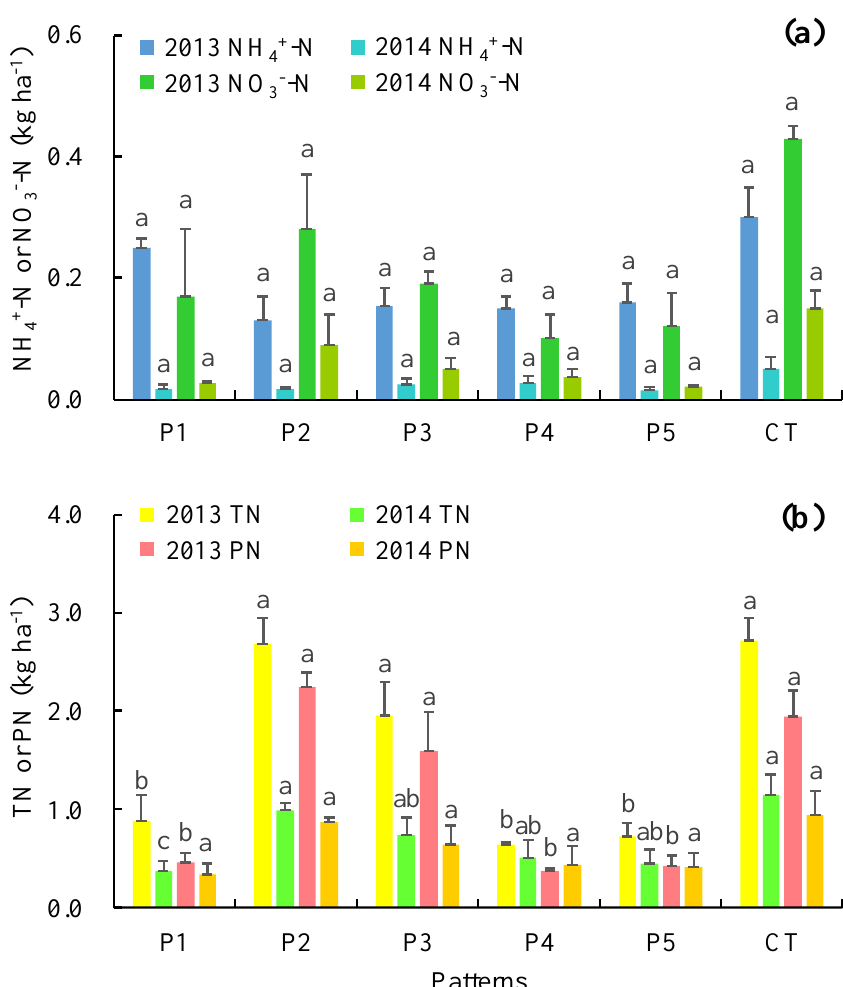
Figure 6. Nitrogen (N) loss from runo ff under di ff erent crop-mulberry planting patterns. The same lettersabovethebarsindicatenosignificantdi ff erenceanddi ff erentlettersindicatesignificantdi ff erences between these groups (p < Table 1. Linear fitting of runoff with the losses of sediment, NH 4+ –N, NO 3- –N, TN, PN, TP, and TDP. Variable